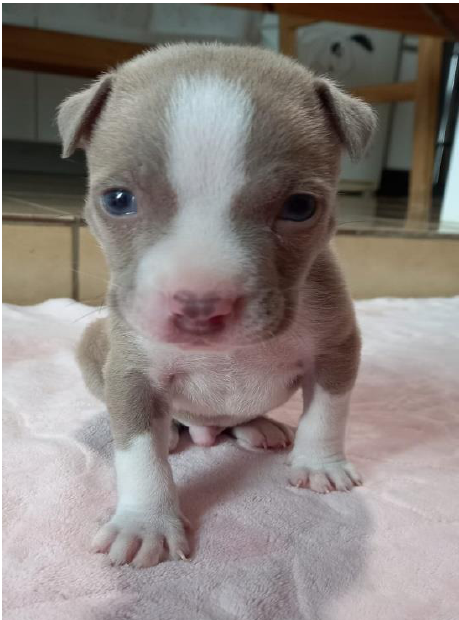
Figure 14. Puppy at 30 days old.